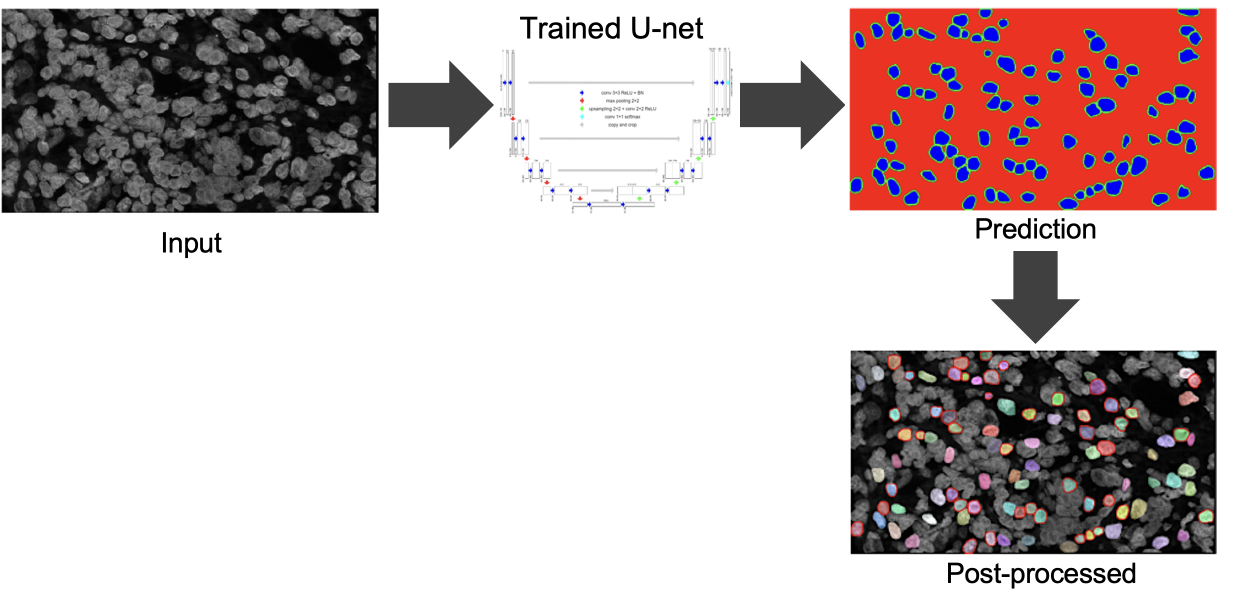
Figure 9. Overview of nuclei